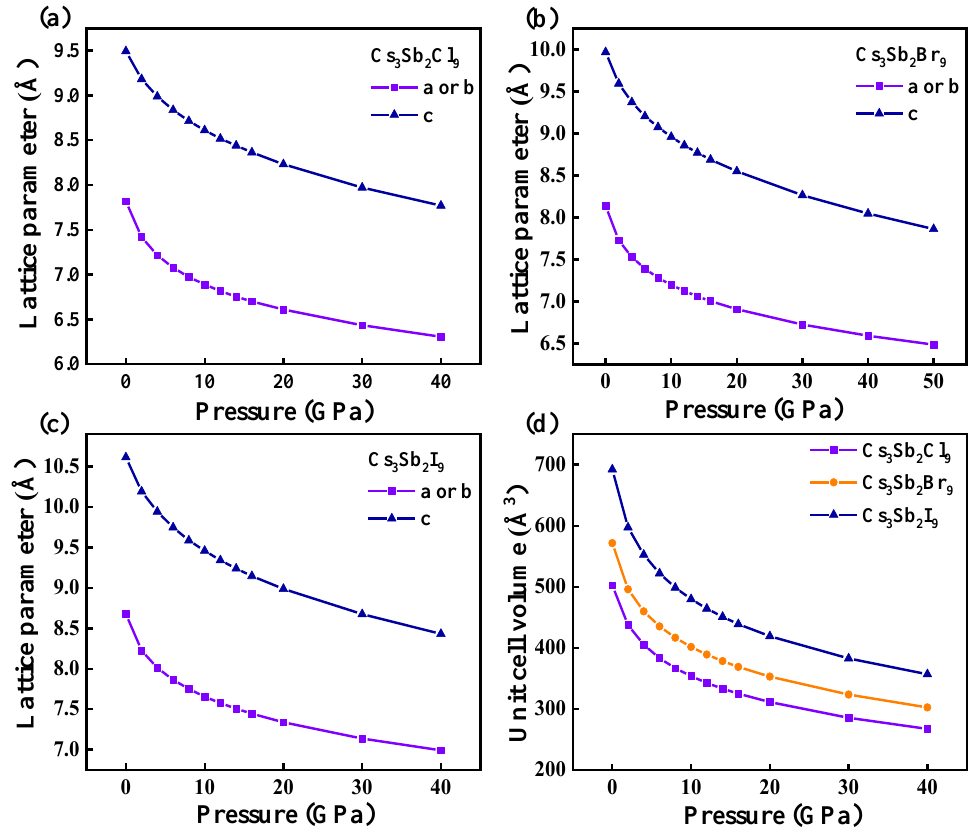
Figure 3. Calculated lattice parameter a, b and c of Cs 3 Sb 2 Cl 9 ( a ); Cs 3 Sb 2 Br 9 ( b ); Cs 3 Sb 2 I 9 ( c ); as a function of pressure: ( d ) lattice volume of Cs 3 Sb 2 X 9 with increasing pressure from 0 to 40 GPa.